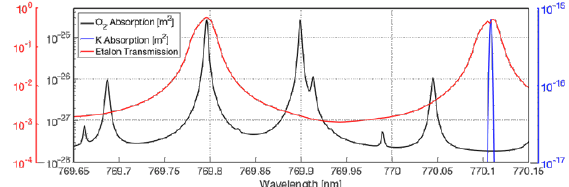
Figure 2: Spectral characteristics of the oxygen A- line, and etalon. The etalon that band, potassium D 1 passes both DIAL wavelengths was designed with a FSR of 157.90 GHz, with measured FSR of 158.13 GHz.